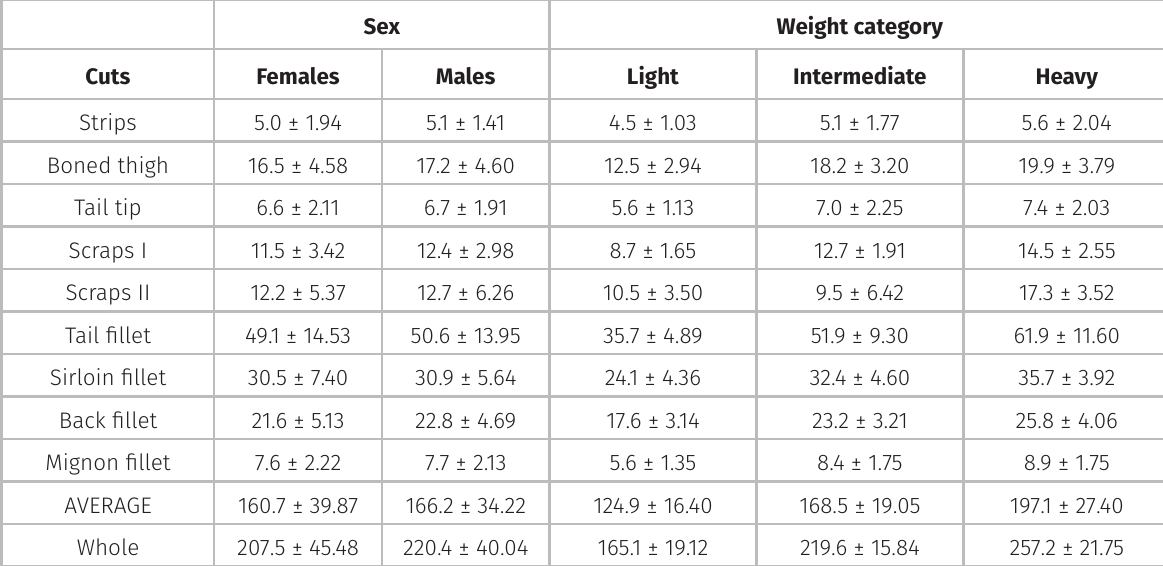
Table IV. Analysis of the revenue of commercial cuts in Brazilian currency (R$) of slaughtered caimans, separated by sex category and weight